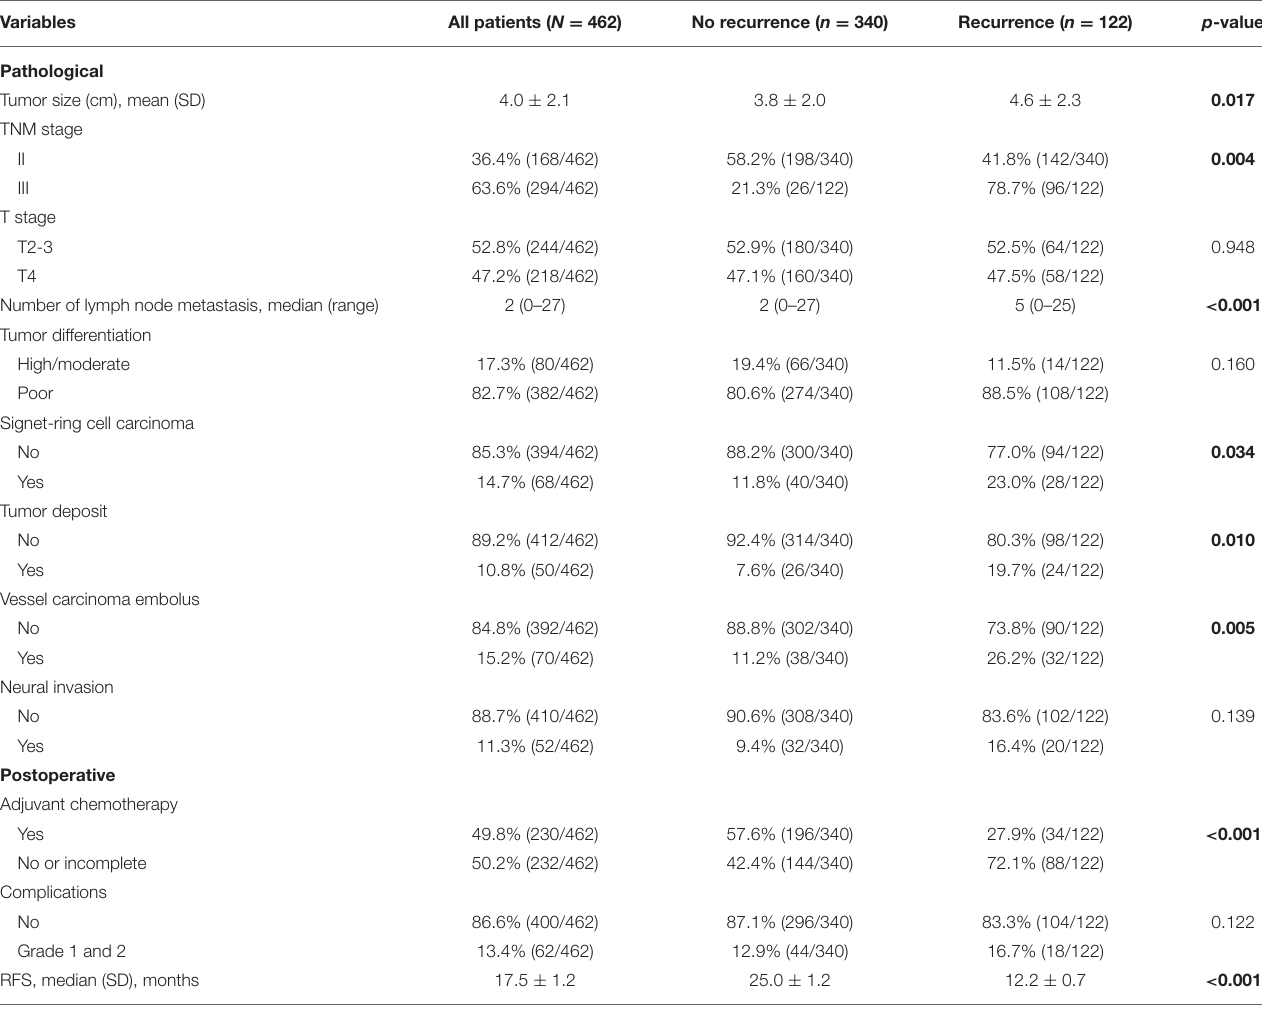
TABLE 2 | The clinical characteristics of all patients ( n = 462). Variables All patients ( N = 462) No recurrence ( n = 340) Recurrence ( n = 122) p -value